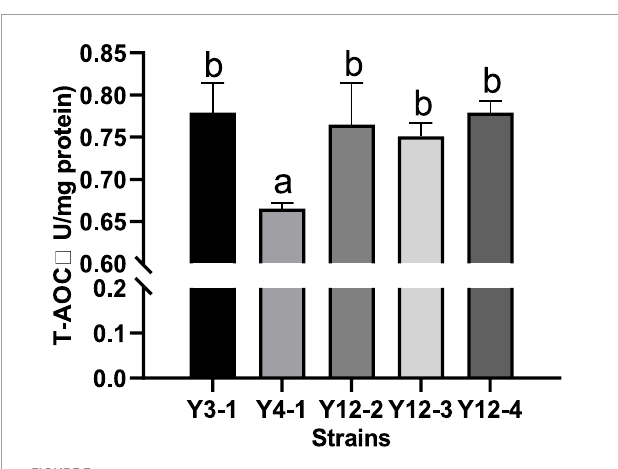
FIGURE3 Determination of total antioxidant capacity (T–AOC) of different yeasts. Different letters indicated significant difference in total antioxidant capacity among different strains ( p <